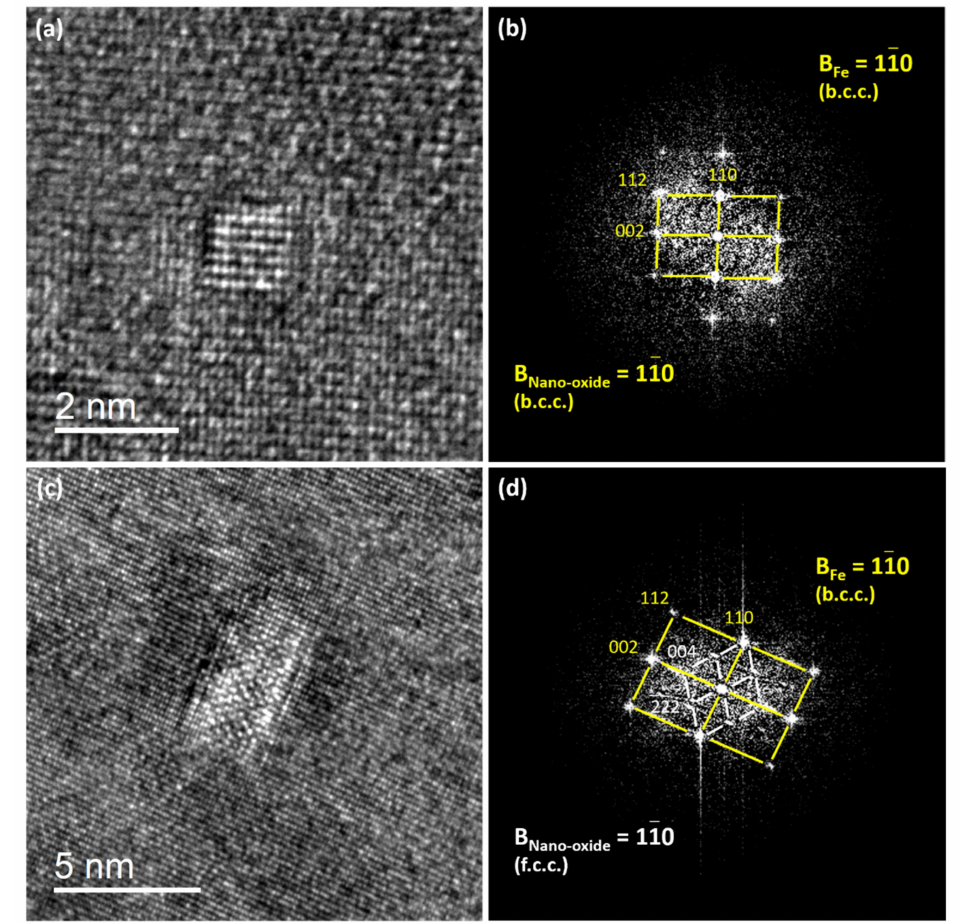
Figure 6. HRTEM images of both nano-cluster (<1.5 nm) and nano-oxide embedded within the ferritic matrix: ( a ) HRTEM image of a nano-cluster, ( b ) corresponding FFT, ( c ) HRTEM image of a nano-oxide, ( d ) corresponding FFT.